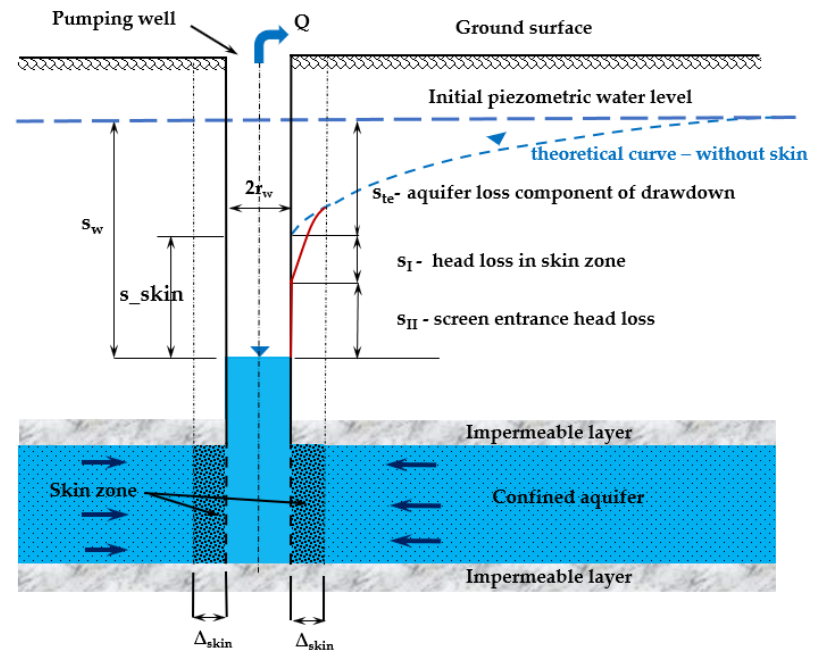
Figure 1. Well diagram with additional resistances on the well wall and in the dam aged zone.